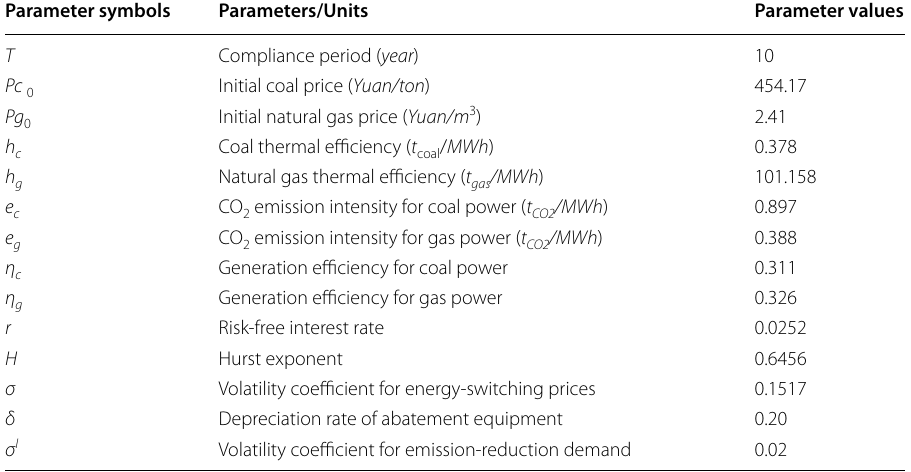
Table 4 Values for all parameters Parameter symbols